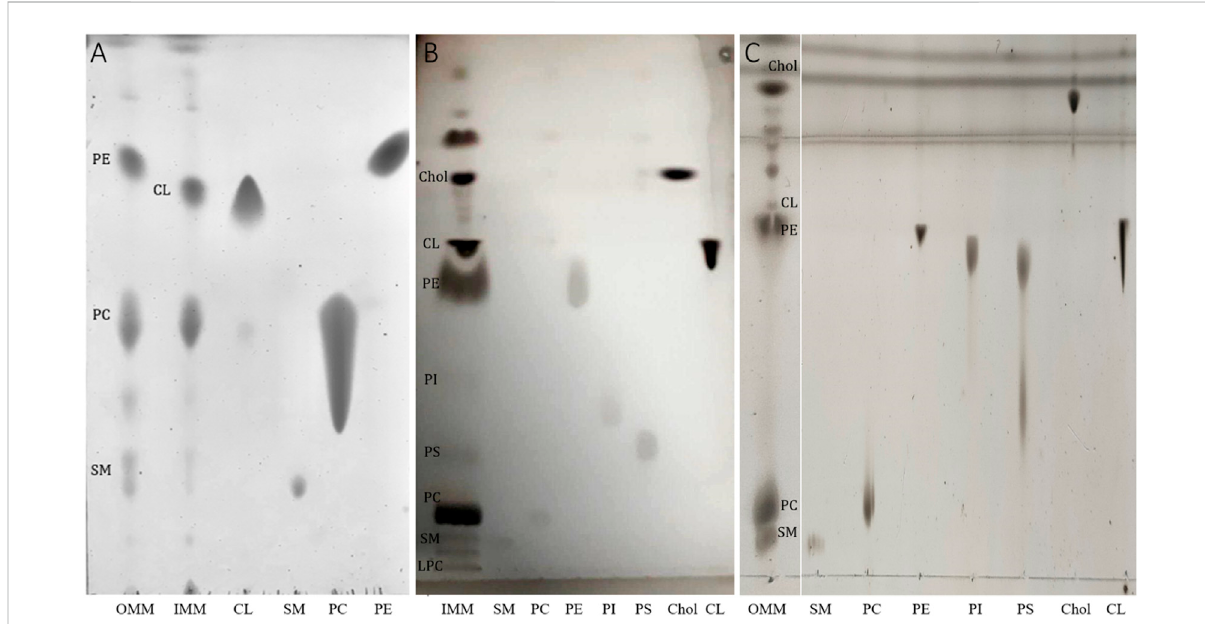
FIGURE 1 (A) Representative TLC showinglipid pro fi lesof OMM and IMMlipid extracts. TLCwaspreparedbyspotting aliquots takenfrom membrane lipid extracts containing a fi xed amount (5 μ g) of total lipid phosphorus. The long tail of the PC standards is observed at high lipid concentration. (B) Representative TLCshowingthe lipid pro fi leof IMM usingthree differentrunning solvents (see methods for details). (C) RepresentativeTLC showing the lipid pro fi le of OMM using three different running solvents. The lipid abbreviations correspond to: Chol, cholesterol; CL, cardiolipin; PE, phosphatidylethanolamine, PS, phosphatidylserine; PI, phosphatidylinositol; phosphatidylcholine; SM,